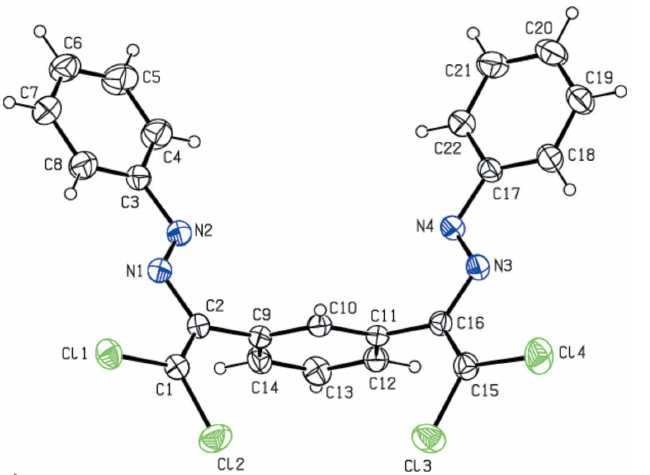
Figure 1 The title molecule with the labelling scheme and 30% probability